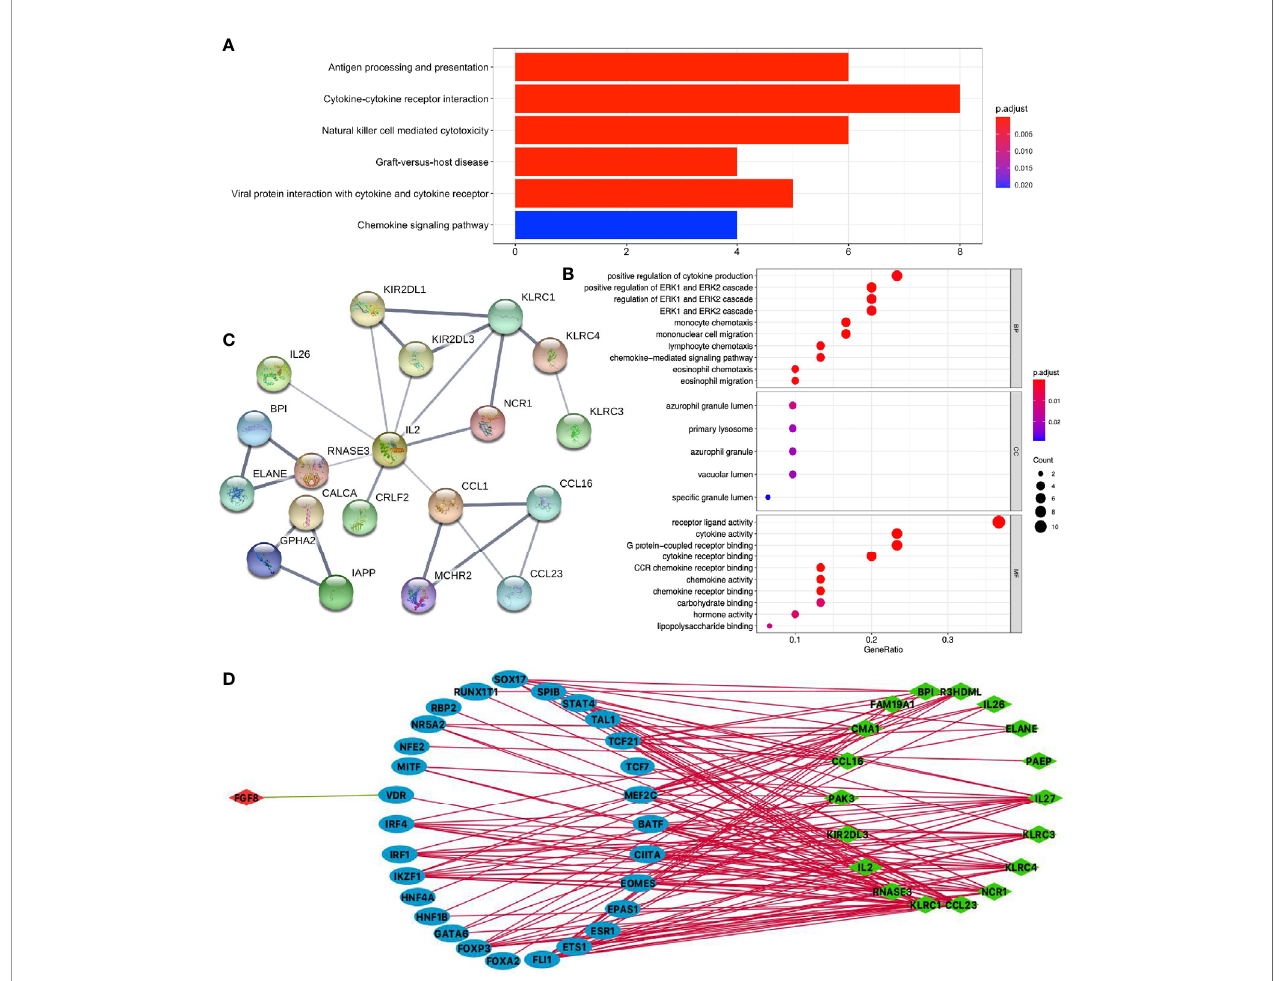
FIGURE 6 | Function enrichment analysis of DEIRGs and TF-DEIRG network in LUSC. (A) KEGG pathway analysis of DEIRGs. (B) GO analysis of DEIRGs. The bar plots and bubble plots show the top terms of biological processes (BPs), cellular components (CCs), and molecular functions (MFs). (C) PPI network of DEIRGs. (D) TF-DEIRG network in LUSC. The blue circle refers to the TFs, the red circle refers to the upregulated DEIRGs, and the green circle refers to the down-regulated DEIRGs. The red line is the positive correlation between TFs and DEIRGs. The green line is the negative correlation between TFs and